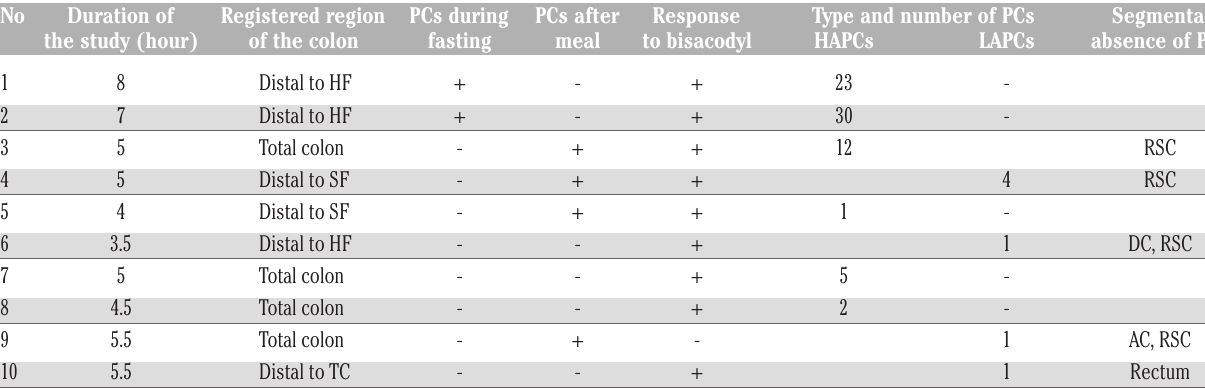
Table 3. Colonic manometry findings of the patients in group #